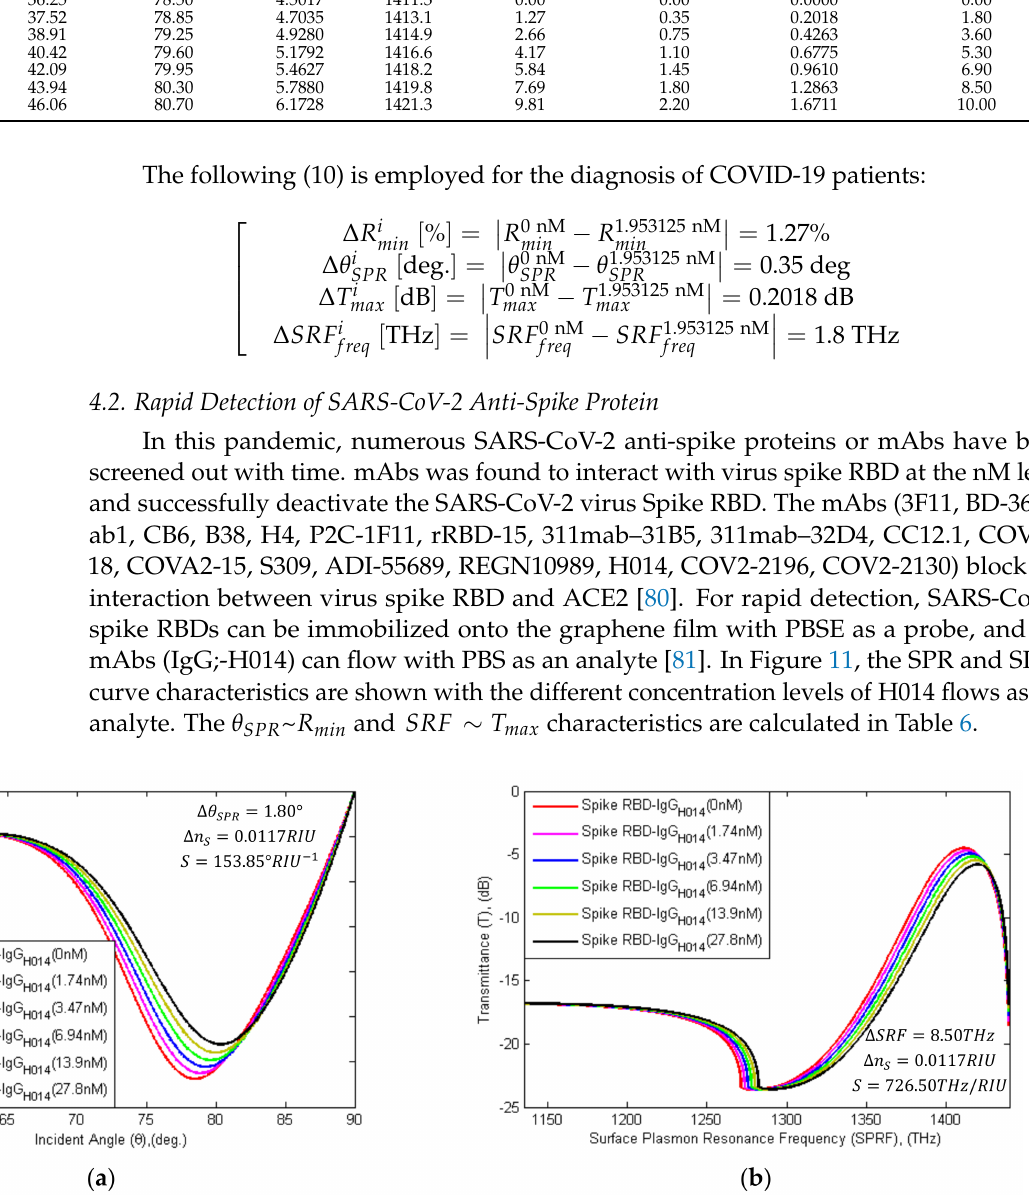
Figure 11. Schematic diagram of ( a ) SPR and ( b ) SPRF characteristics of Bk 7 /Au(50 nm)/PtSe 2 (2 nm)/Graphene (1.7 nm) substrates with immobilized SARS-CoV-2 spike RBDs as the ligand and different concentration levels of IgG-H014 (concen- tration of 1.74 nM to 27.8 nM) as the